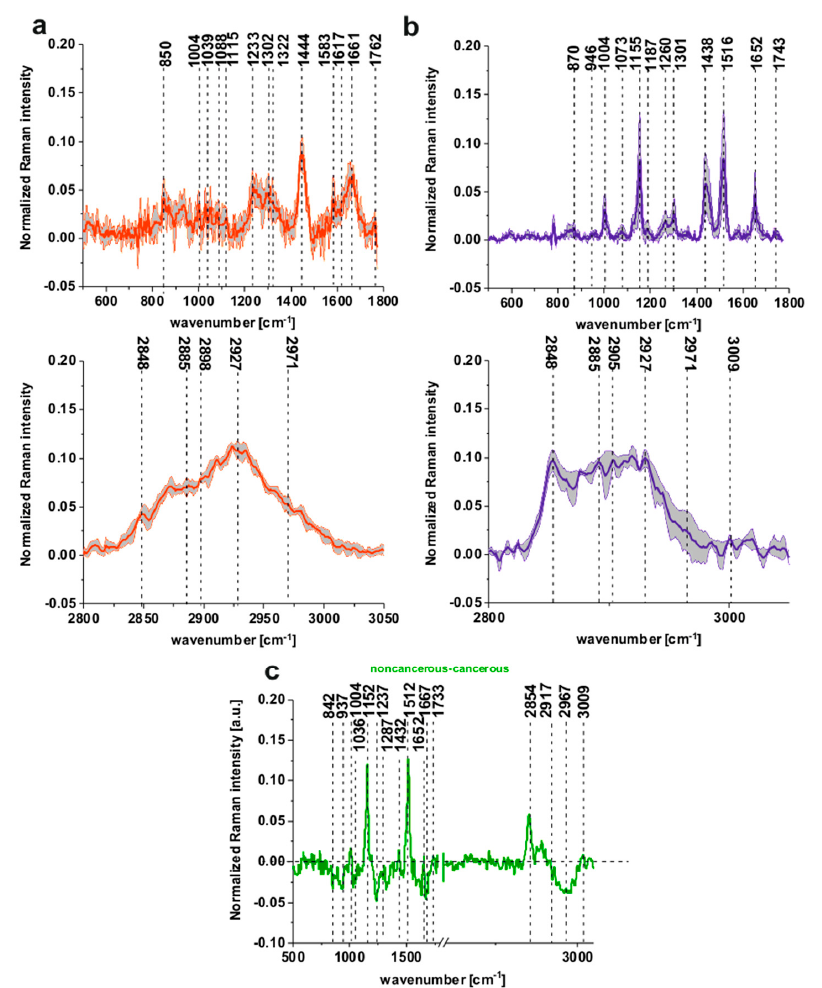
Figure 2. The average Raman spectra based on 20 single spectra of the cancerous (tubular carcinoma, cancer stage G2) tissue ( a ) (red line) and the noncancerous tissue ( b ) (blue line), the differential spectrum between the normalized mean Raman spectra of the noncancerous and the cancerous (tubular carcinoma, cancer stage G2) human colon tissues ( c ), patient P3.